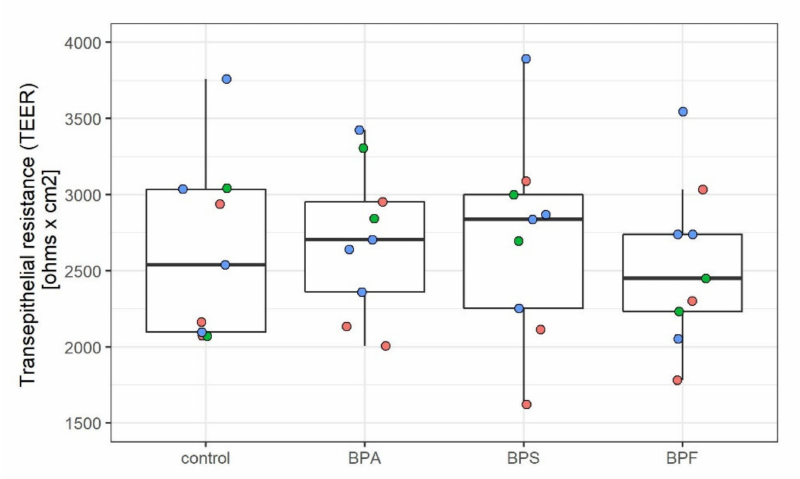
Figure 1. Effect of bisphenols on barrier integrity. Each dot represents the average transepithelial resistance (TEER) of three transwells within one experiment, and the overlying box plots depict median value and the interquartile range (IQR) plus whiskers up to the lowest/highest value <1.5 × IQR. Red = BMECs derived with protocol 1, i.e., hypoxia 10 days protocol ( n = 3), Green = BMECs derived with protocol 2, i.e., normoxia 8 days protocol ( n = 2), Blue = BMECs derived with protocol 3, i.e., protocol 2, but frozen day 6 and exposed only in transwells (48 h) ( n = 4). The Kruskal–Wallis test showed no significant differences between the treatment